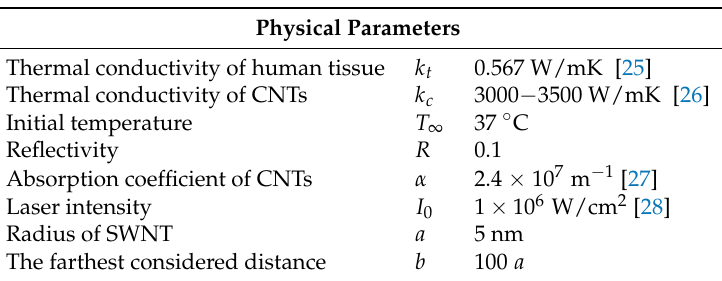
Table 1. Physical parameters of cancer cells, CNTs and